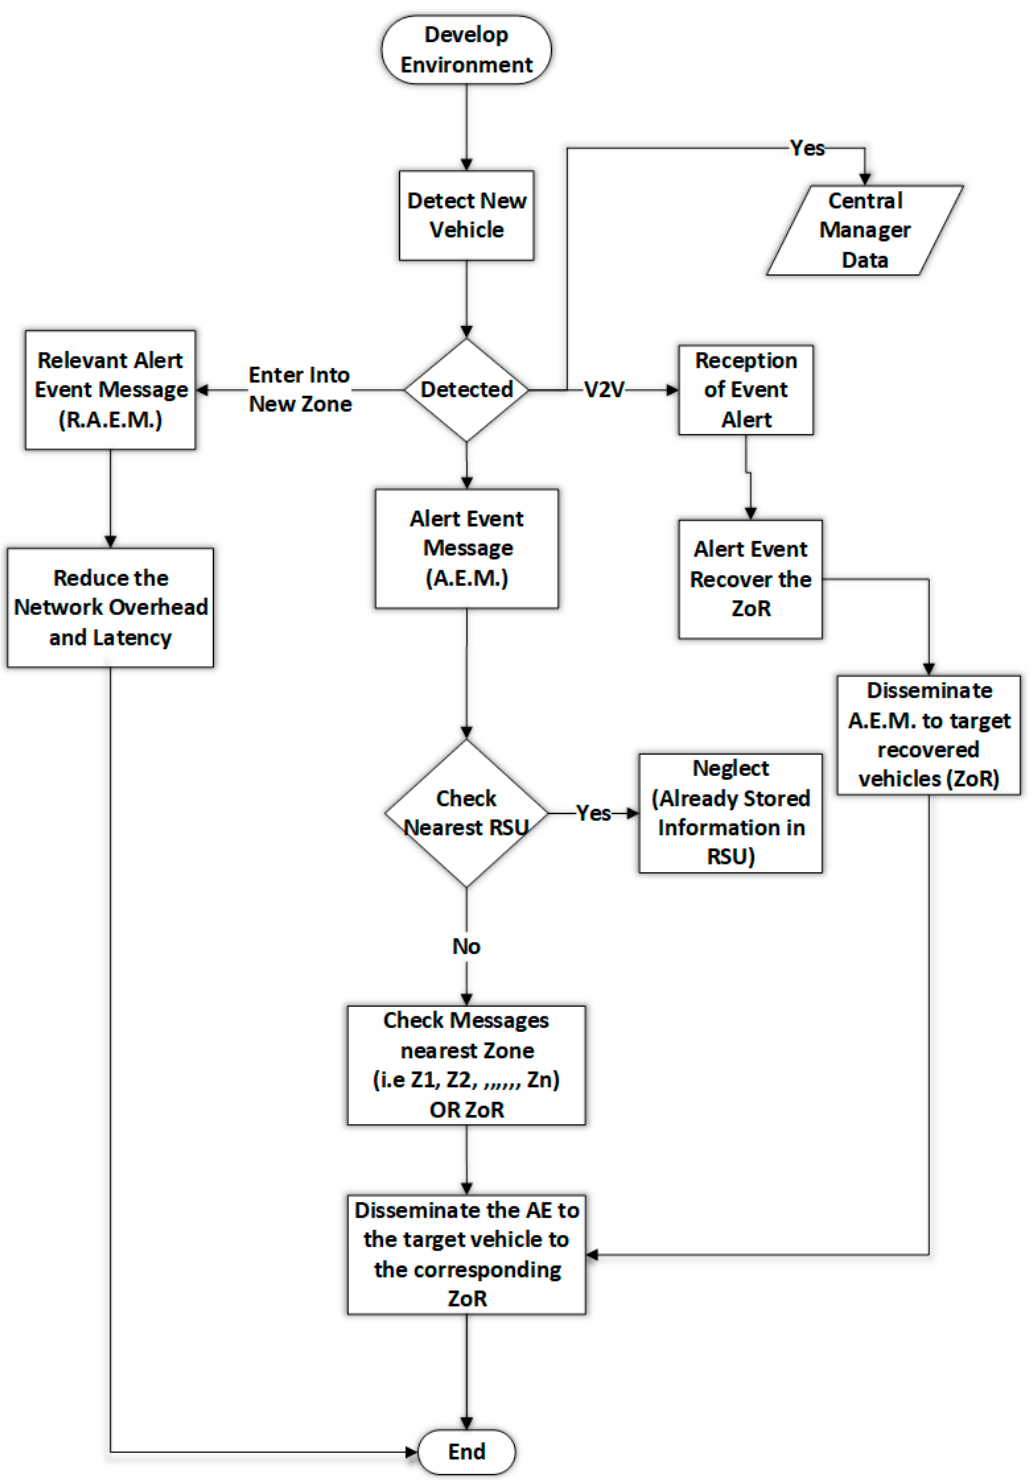
Figure 4. Logical workflow of the proposed methodology.